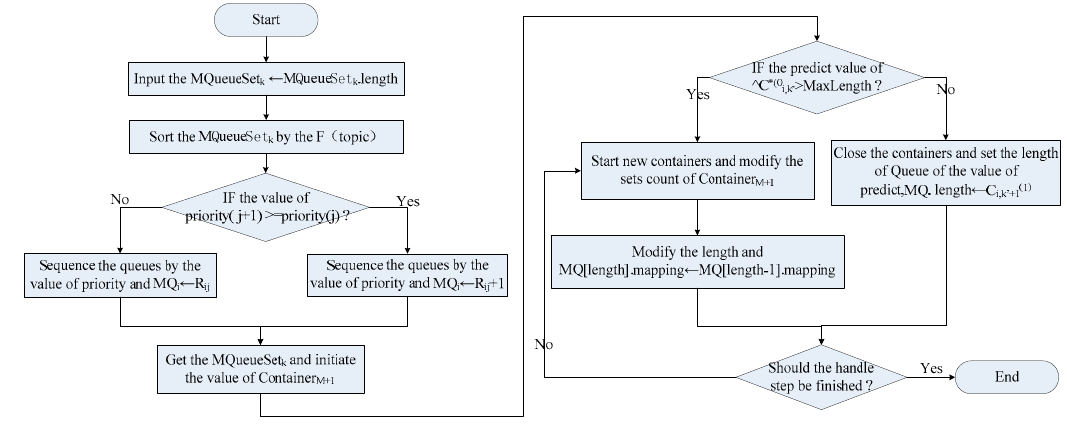
Figure 4. Flowchart of elastic management for containers.